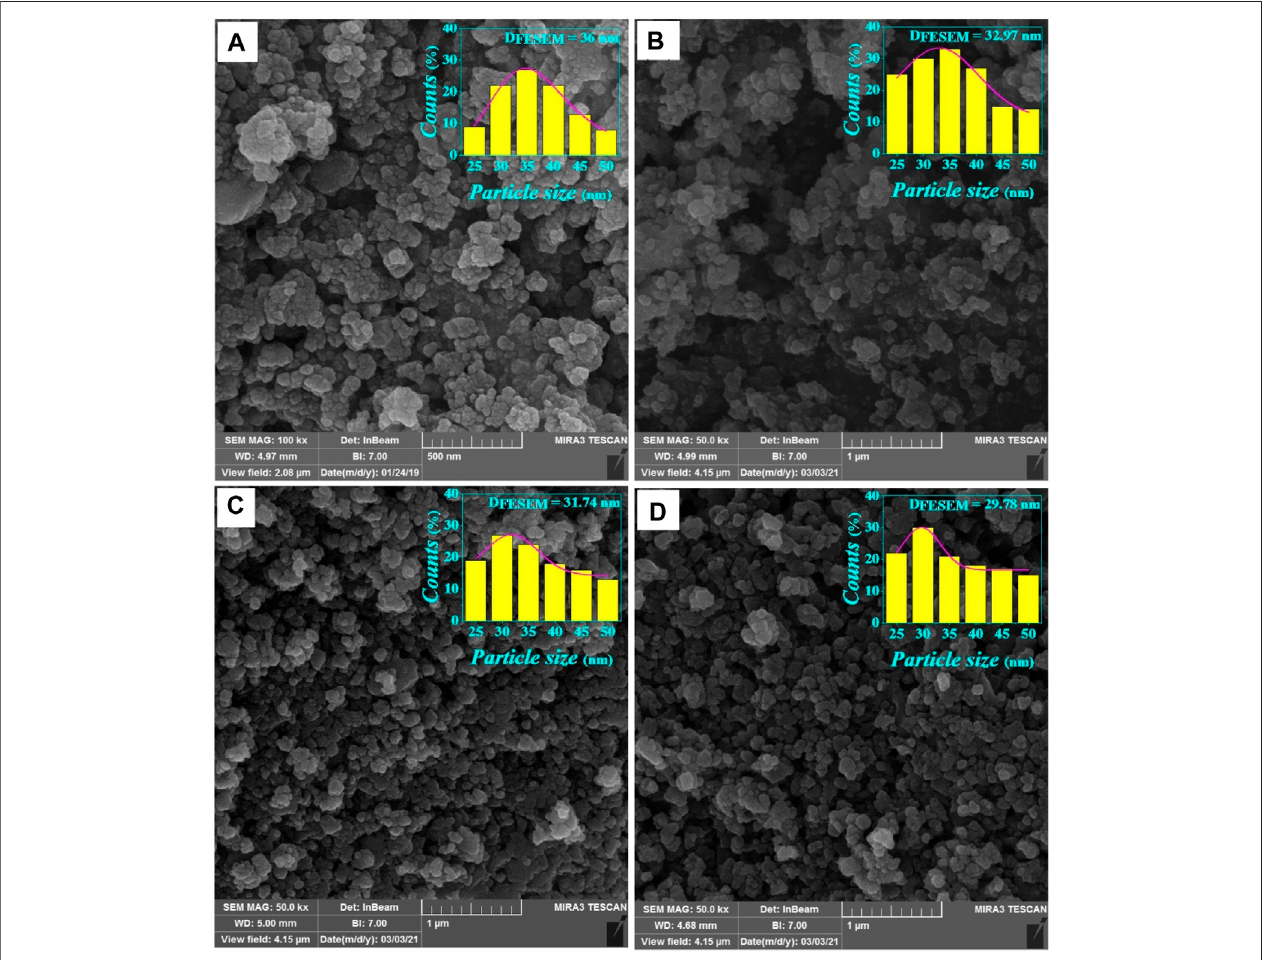
FIGURE4| TheFE-SEMimagesandlog-normaldistributiondiagramofCd x Mg 0.30- x Cu 0.20 Zn 0 . 50 Fe 2 O 4 for (A) x (cid:1) 0.00, (B) x (cid:1) 0.05, (C) x (cid:1) 0.10,and (D) x (cid:1) 0.15.